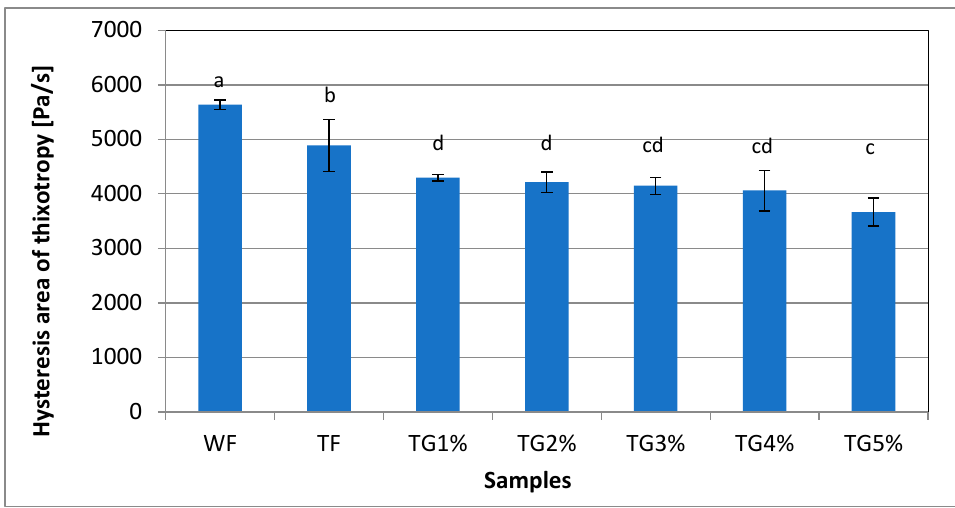
Figure 4. Hysteresis area of thixotropy of wheat flour, triticale flour and system of triticale flour with vital gluten. The values in the chart marked with the same letters do not differ significantly at the significance level of 0.05.